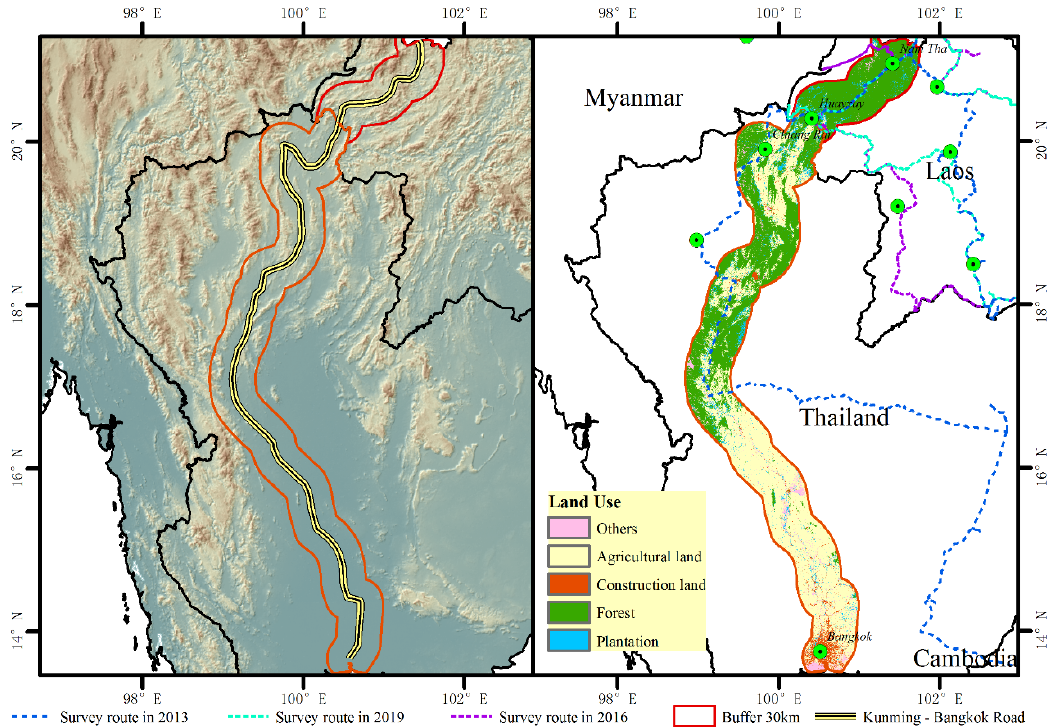
Figure 1. Maps of the 30 km buffer area of the Kunming–Bangkok Highway and its topography (ASTER GDEM), showing land use in 2018 as well as the results of field surveys in 2013, 2016, and 2019.